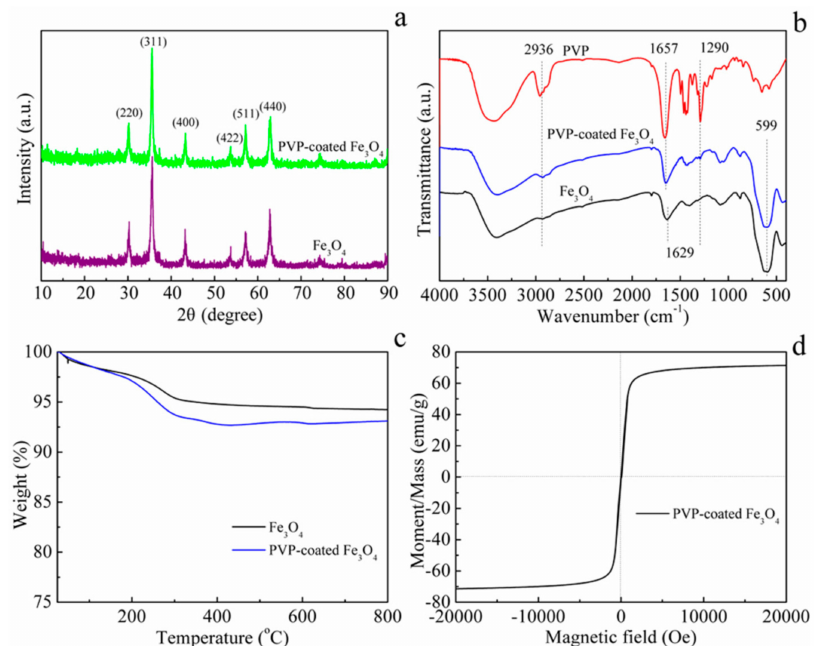
Figure 2. XRD patterns ( a ), FTIR spectra ( b ), TGA curves ( c ), and magnetic hysteresis loop ( d ) of the synthesized MNPs (Fe 3 O 4 : S0, PVP-coated Fe 3 O 4 :